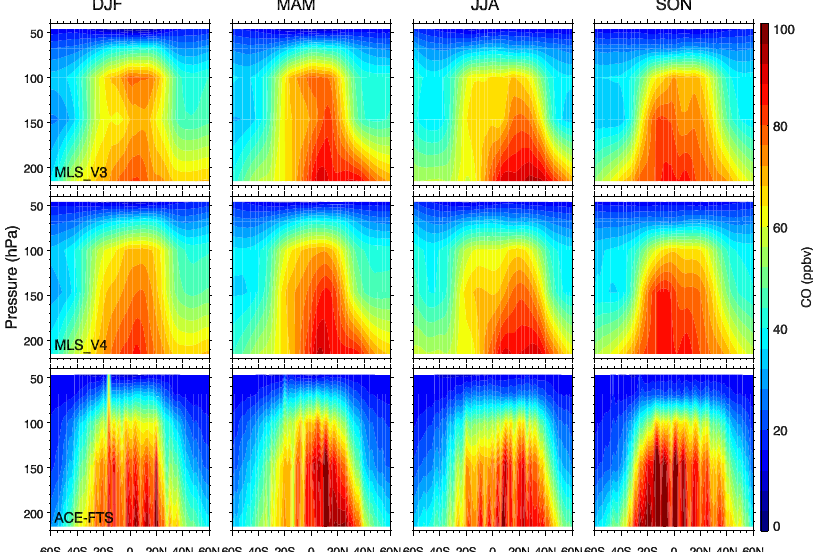
Figure A1. Vertical distribution of zonal mean CO mixing ratio in the pressure–latitude cross section during different seasons (DJF, MAM, JJA and SON) from (top row) MLS Version 3 CO data; (middle row) MLS Version 4 CO data; (bottom row) ACE-FTS CO data with MLS averaging kernels (AKs)